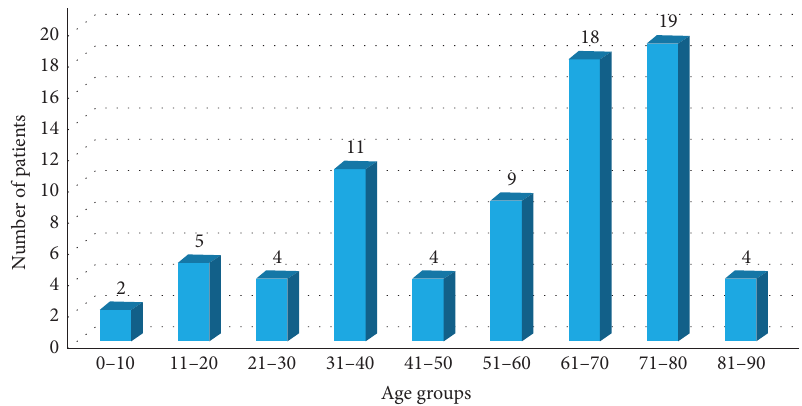
Figure 1: Patient’s numbers with regrafted cornea in different age groups. Table 1: Prevalence of different causes of corneal